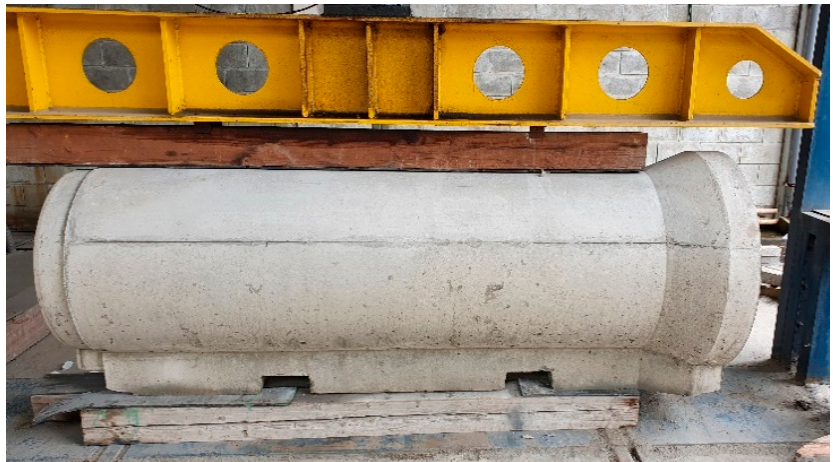
Figure 12. Three edge bearing test for complex cross-section reinforced concrete pipe.